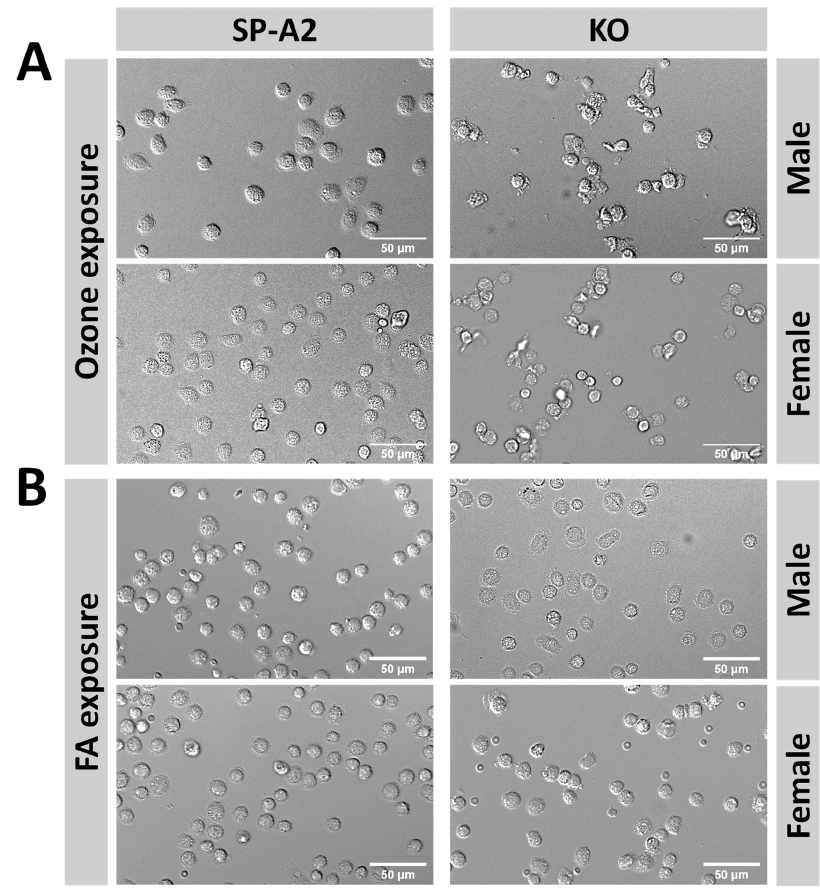
Figure 1. Typical morphological appearance of alveolar macrophages (AM) from SP-A2 and knockout (KO) mice exposed to ozone ( A ) or FA ( B ) showing distressed cell morphology of AM from both male and female KO mice only after ozone